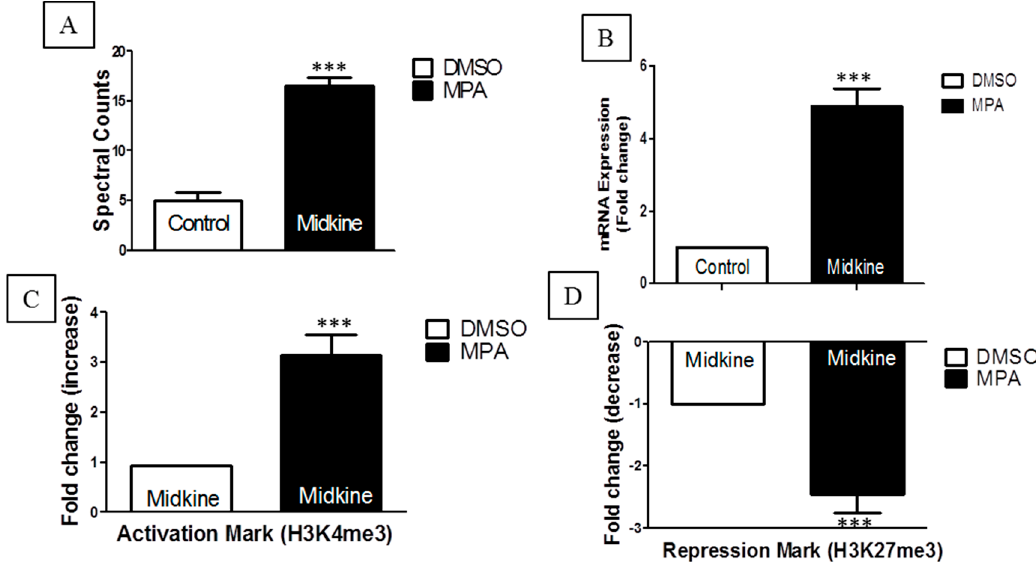
Figure 2. Cont . Figure 2.